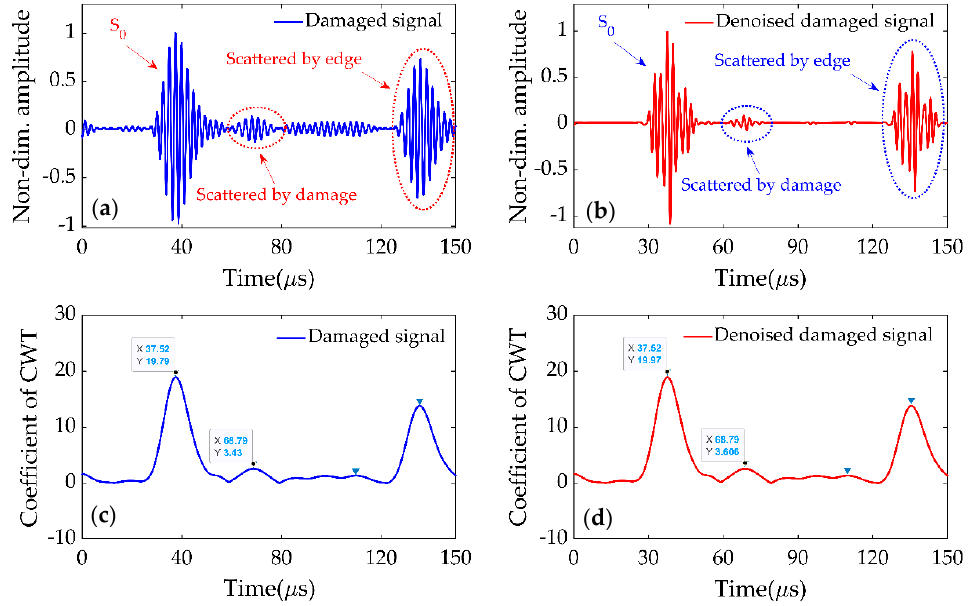
Figure 18. ( a ) Received signal at P2. ( b ) Denoised signal of ( a ). ( c ) CWT of signal ( a ). ( d ) CWT of signal ( b ).